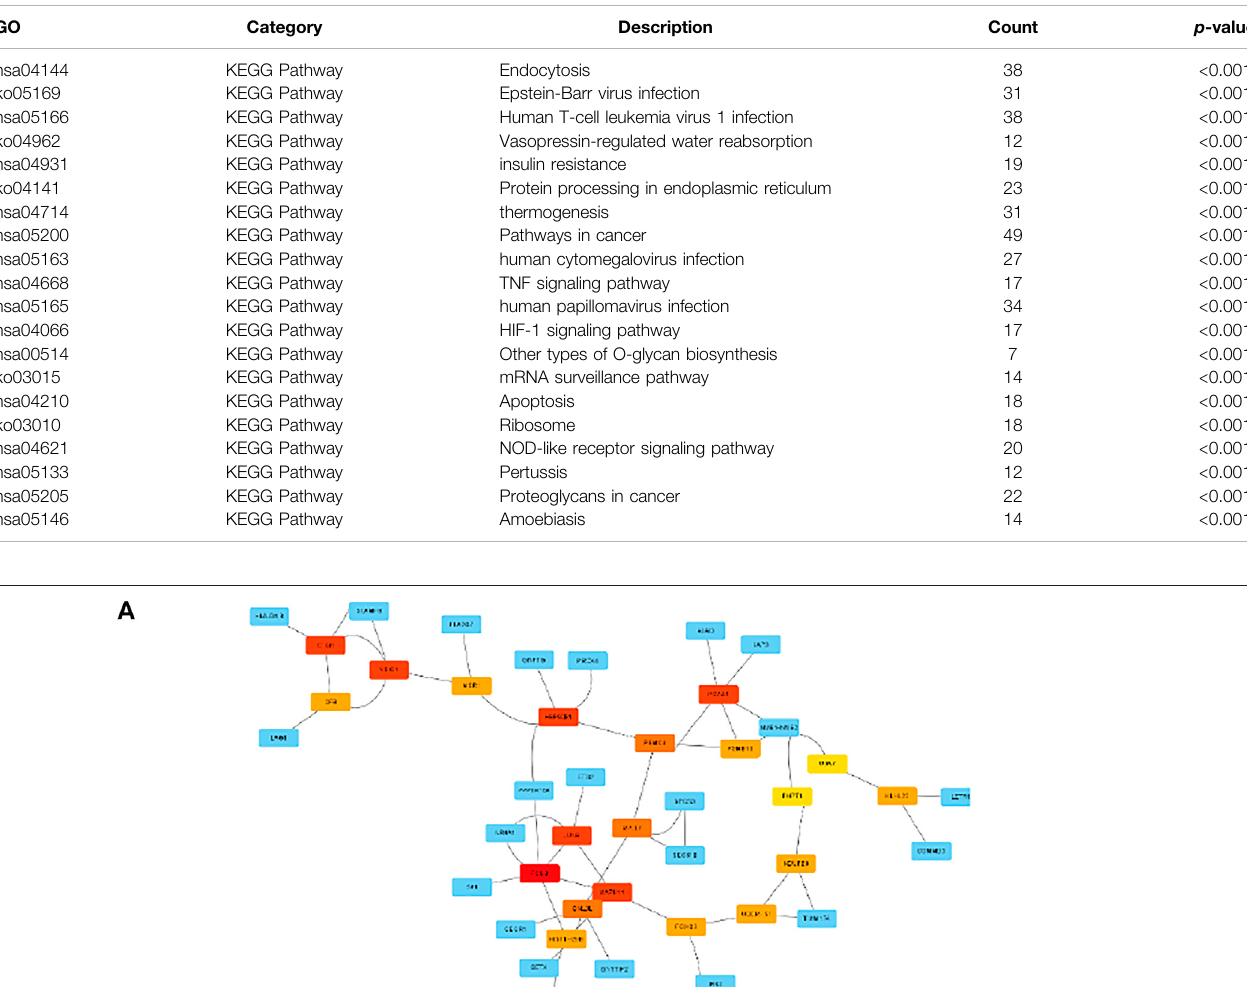
TABLE 4 | KEGG analysis of WCGNA grey module.